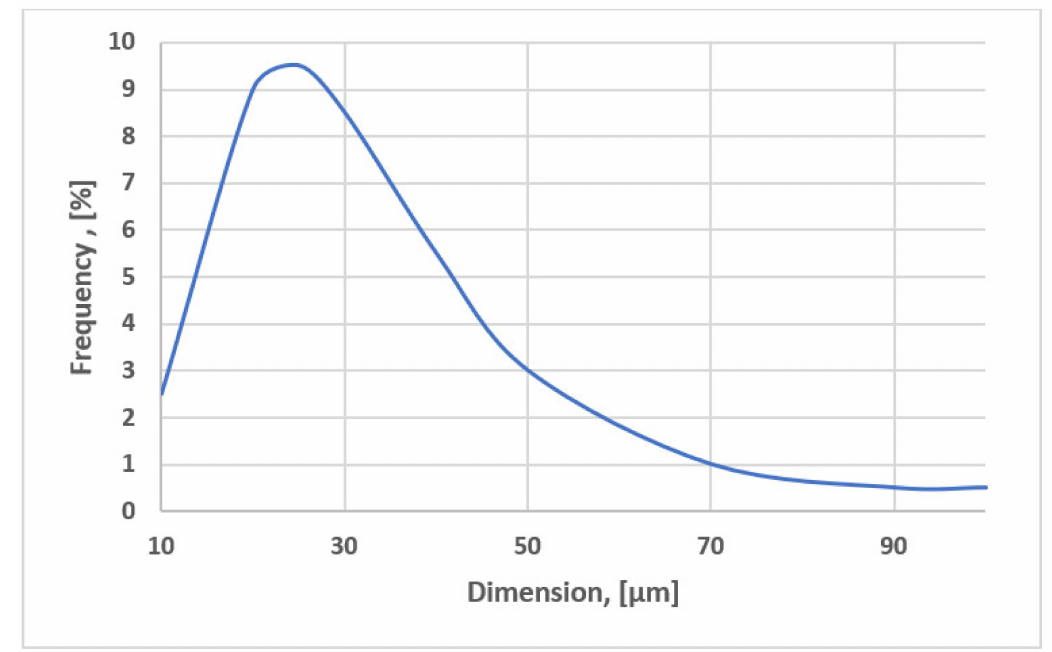
Figure 3. Distribution of the particle size classes for sintering sludge, class 10–100 µ m.